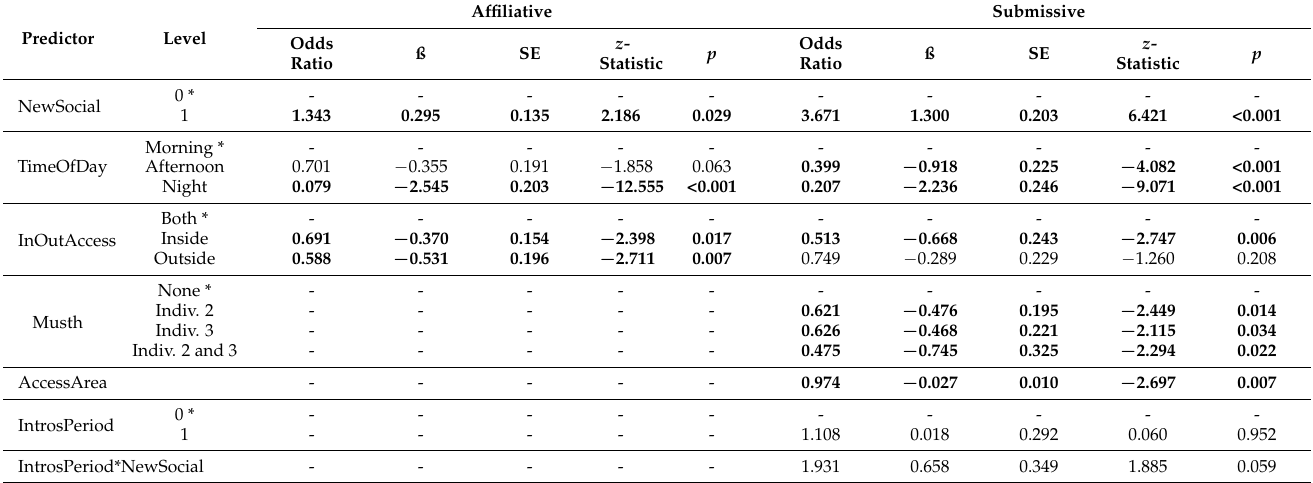
Table A10. New social GLMER model parameter estimates for affiliative and submissive response variables. Generalized linear mixed-effect model results of associations between predictor variables (fixed effects) and behavioral response variables for all focal animals. ß = Beta coefficients from model outputs: positive values indicate an increase in odds compared to the reference level while negative values indicate a decrease in odds compared to reference level; SE = standard error of beta coefficients; Wald X 2 = Chi-squared statistic from Wald test with df = 1; p = p -value from Wald test. * indicates reference level. Bold signifies statistical significance ( p < 0.05).